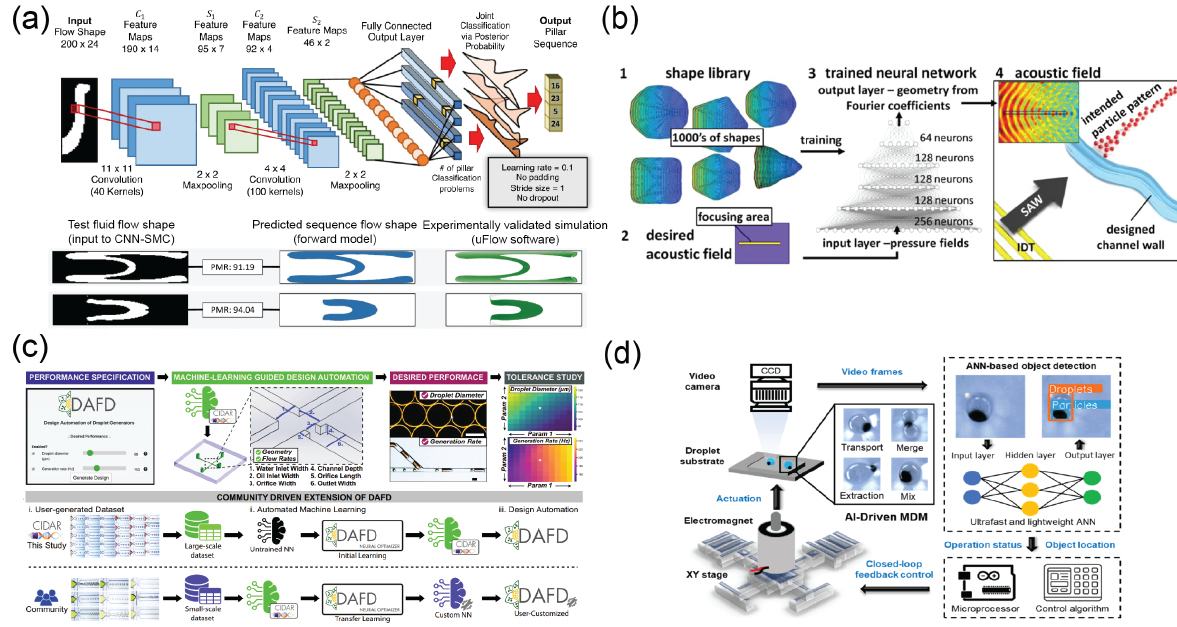
Figure 2. Selected examples of AI-enhanced smart platforms and automation. ( a ) A CNN framework to predict the outcome of flow sculpturing by micropillar microstructures [27]. Reproduced